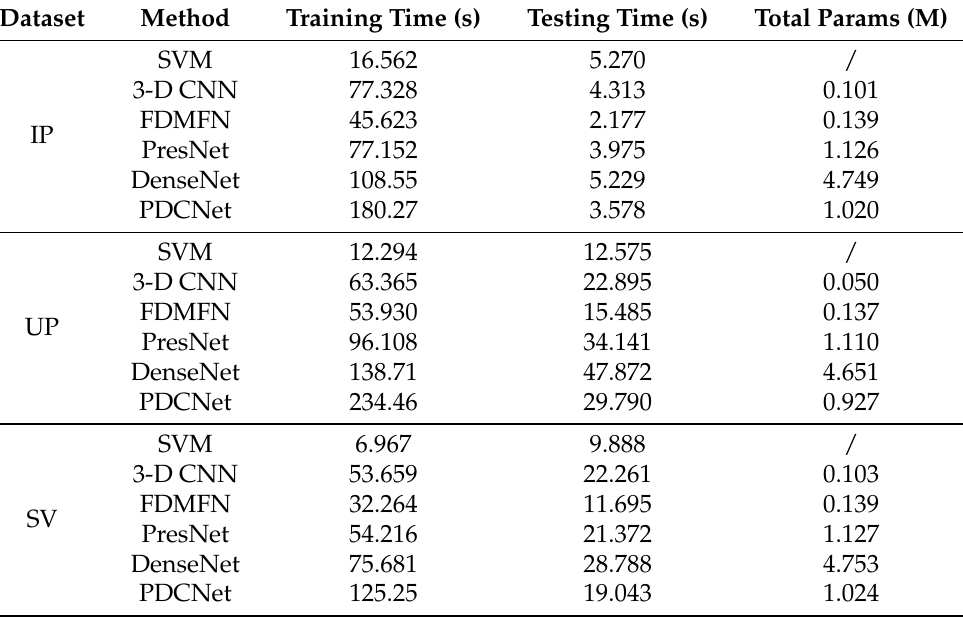
Table 13. Comparison of networks parameters and running